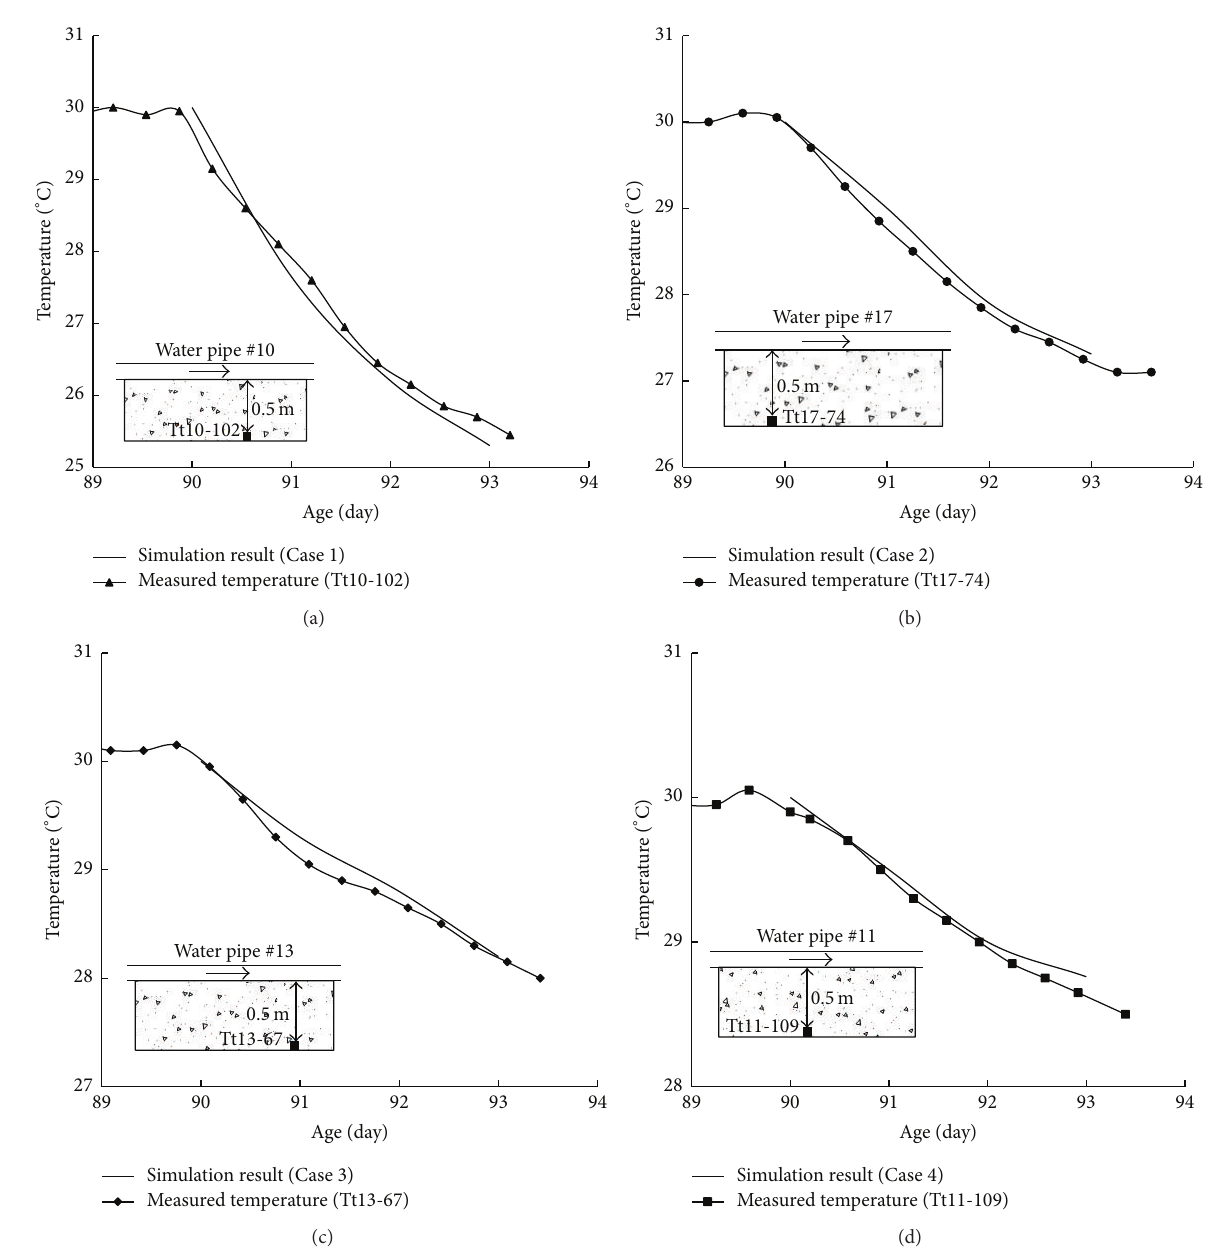
Figure 10: Temperature history of the bottom slice: (a) Case 1, (b) Case 2, (c) Case 3, and (d) Case